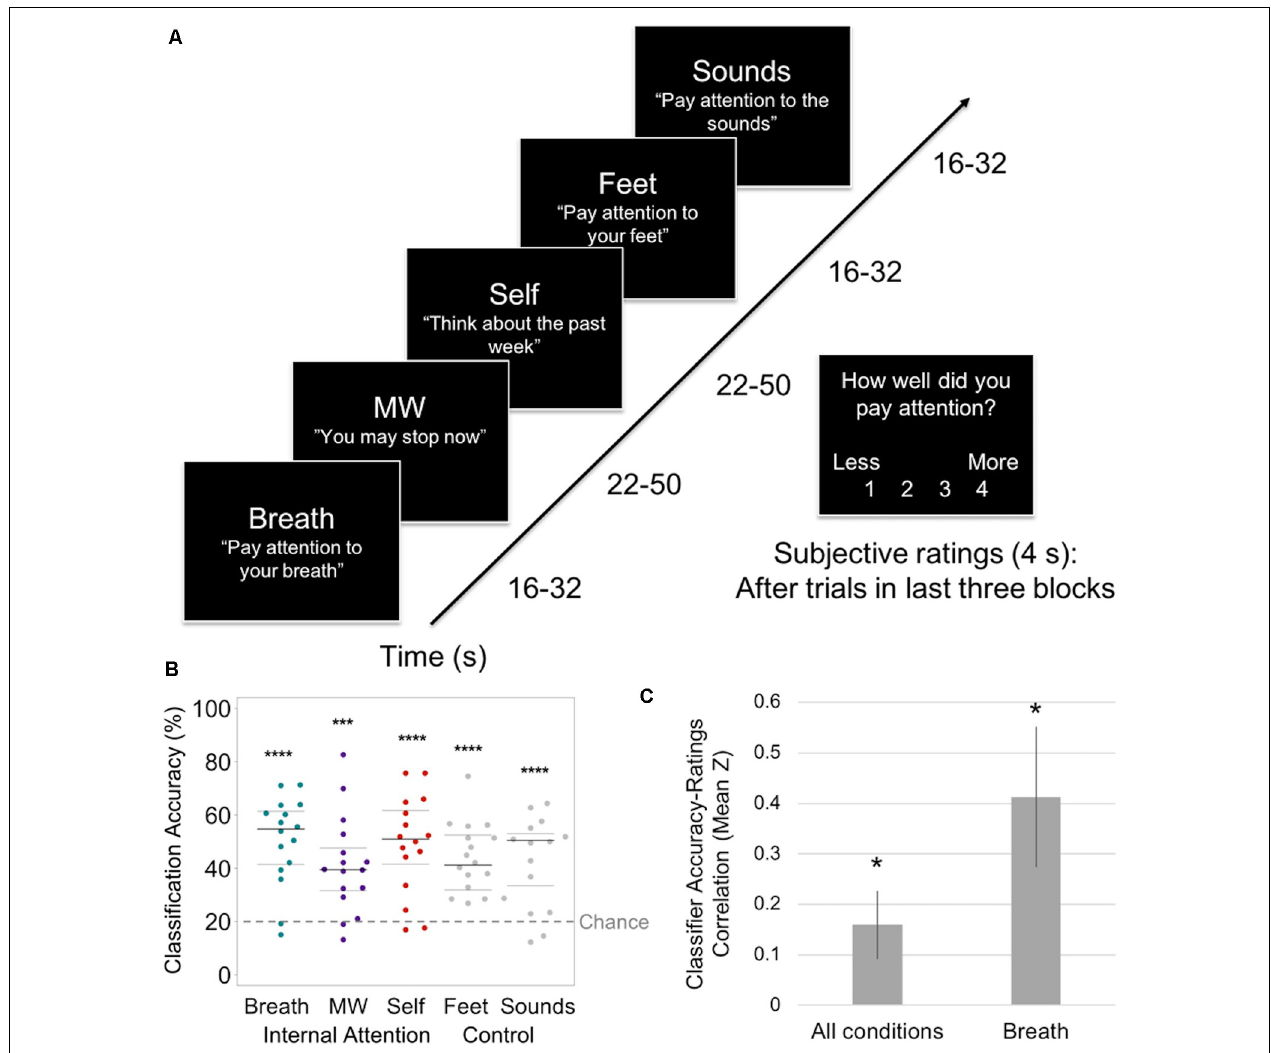
FIGURE 2 | EMBODY Step 1: classifier training of internal mental states. (A) Internal Attention (IA) task. With eyes closed, participants were directed via 2-s auditory instructions to pay attention to five internal mental states for brief periods (16–50 s). The IA task-directed attention to three mental states relevant for breath meditation [Breath, mind wandering (MW), and Self], and two control mental states [attention to the Feet (another area of the body) and ambient MRI Sounds (consistent external distractor)]. The example auditory instructions are displayed in quotes. MW was induced by instructing participants to stop paying attention and let their minds attend to whatever they wanted. Conditions were randomized over six IA blocks in four orders, with 72 s of data collected from each condition in each block (total 432 s/condition). For the last half of IA task trials, subjective ratings of attention were collected after each trial (except MW) using a button box (1 = less, 4 = more). (B) From the IA task, the prediction accuracy of the classifier for identifying internal states of attending to the Breath, MW, and Self, and control conditions of attending to the Feet and Sounds. Beeswarm plots present each data point, the median (bold black line), and ± 25th percentile range (gray lines) of the mean prediction accuracy for all data in each condition ( n = 432) across all subjects. Statistical significance was determined by a one-sample two-sided t -test against theoretical chance-level for classification of five categories (20%, denoted by a dashed line). *** t (15) = 4.65, p < 0.001, **** t s 15 > 5.67, p s < 0.0001. (C) Mean z -scores representing the within-subject correlation between trial-level classifier training accuracy and subjective ratings of attention (administered during the last half of IA task trials) for all conditions (except MW) and breath trials only. Error bars indicate standard error of the mean. * p < 0.05.